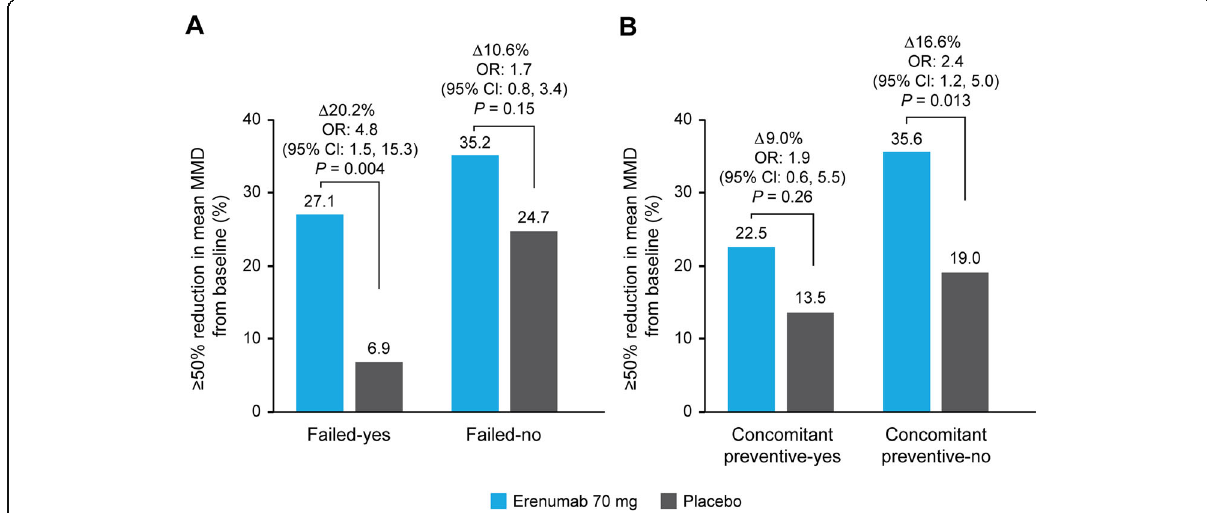
Fig. 2 ≥ 50% reduction in mean MMD from baseline in ( A ) failed-yes/no and ( B ) concomitant preventive-yes/no subgroups. CI confidence interval, MMD monthly migraine days, OR odds ratio